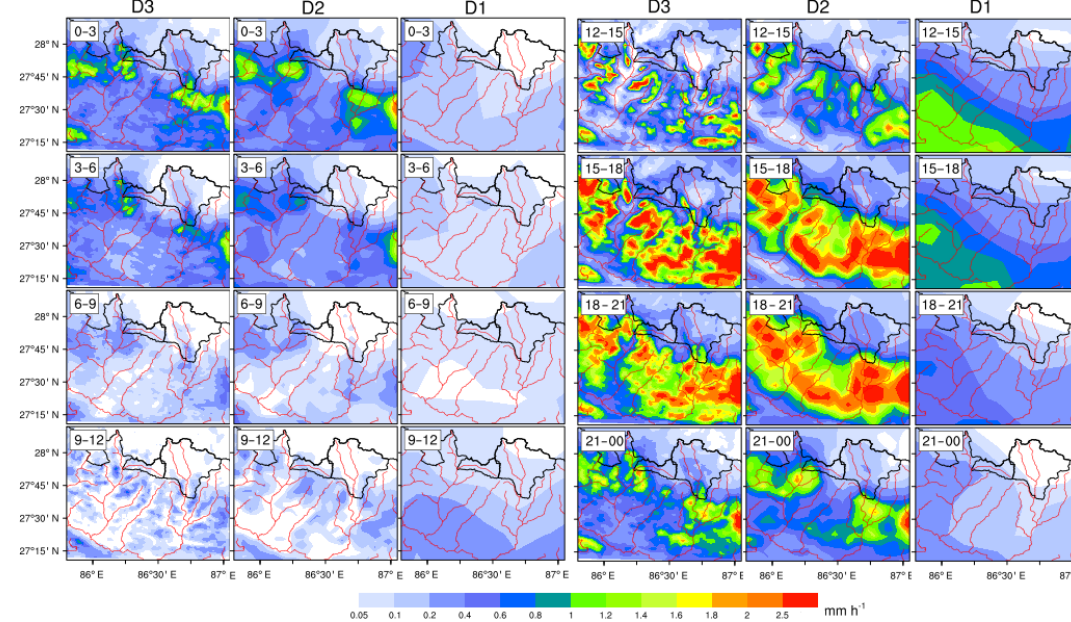
Figure 16. Spatial distribution of three-hourly (local time) average precipitation (mmh − 1 ) plot during the monsoon season for three different WRF resolutions. Rivers in the Nepal region are delineated in red, and Rolwaling (left) and Khumbu (right) are overlaid in black.